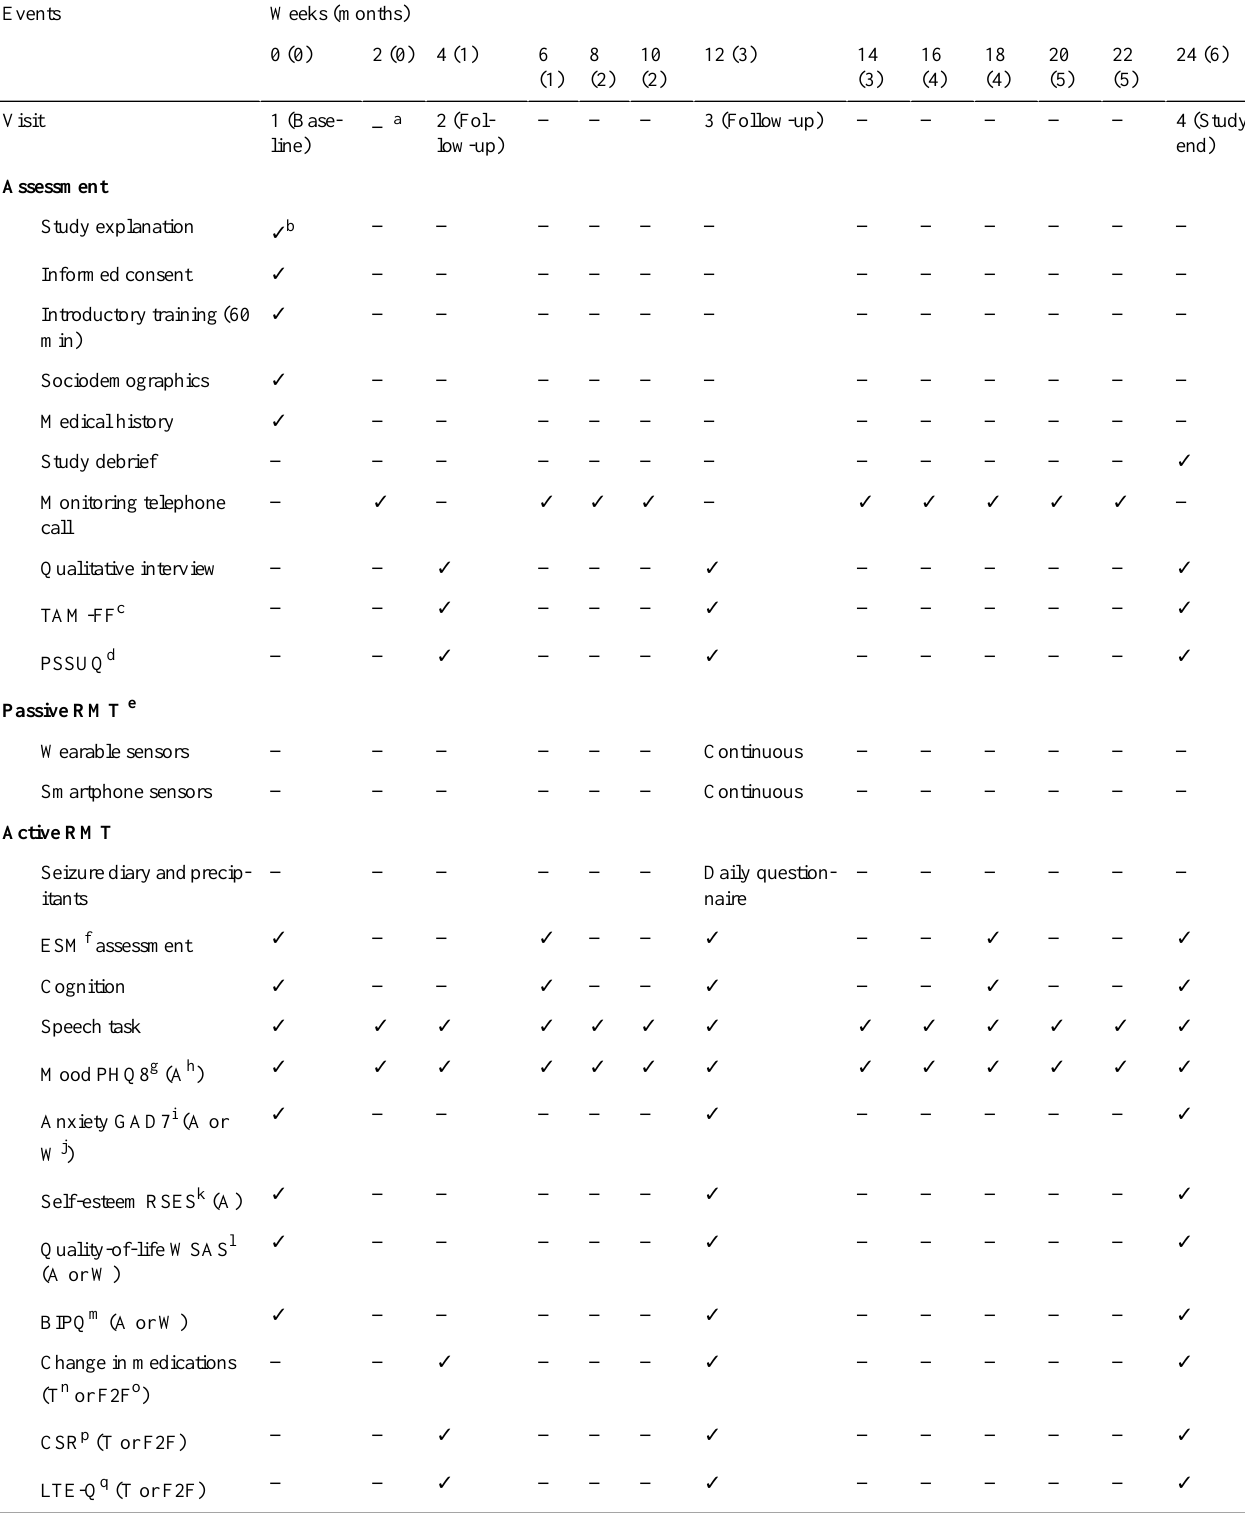
Table 1. Schedule of events for Remote Assessment of Disease and Relapse Epilepsy. Weeks